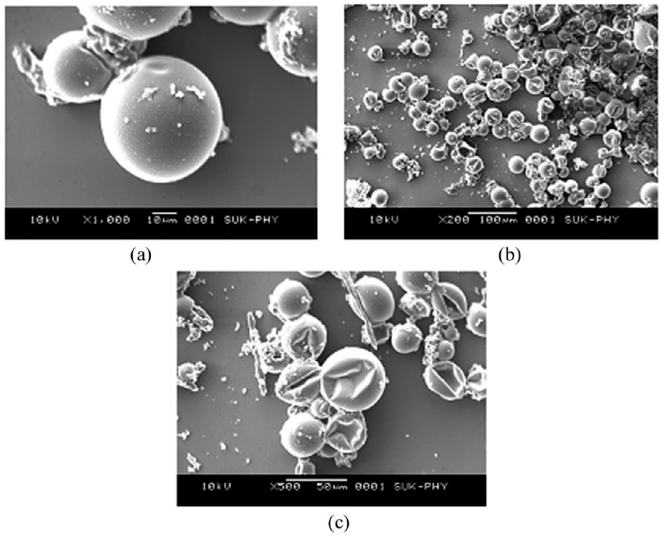
Figure 18. SEM micrographs ( a – c ) of phenol formaldehyde microcapsules containing neem oil [201].